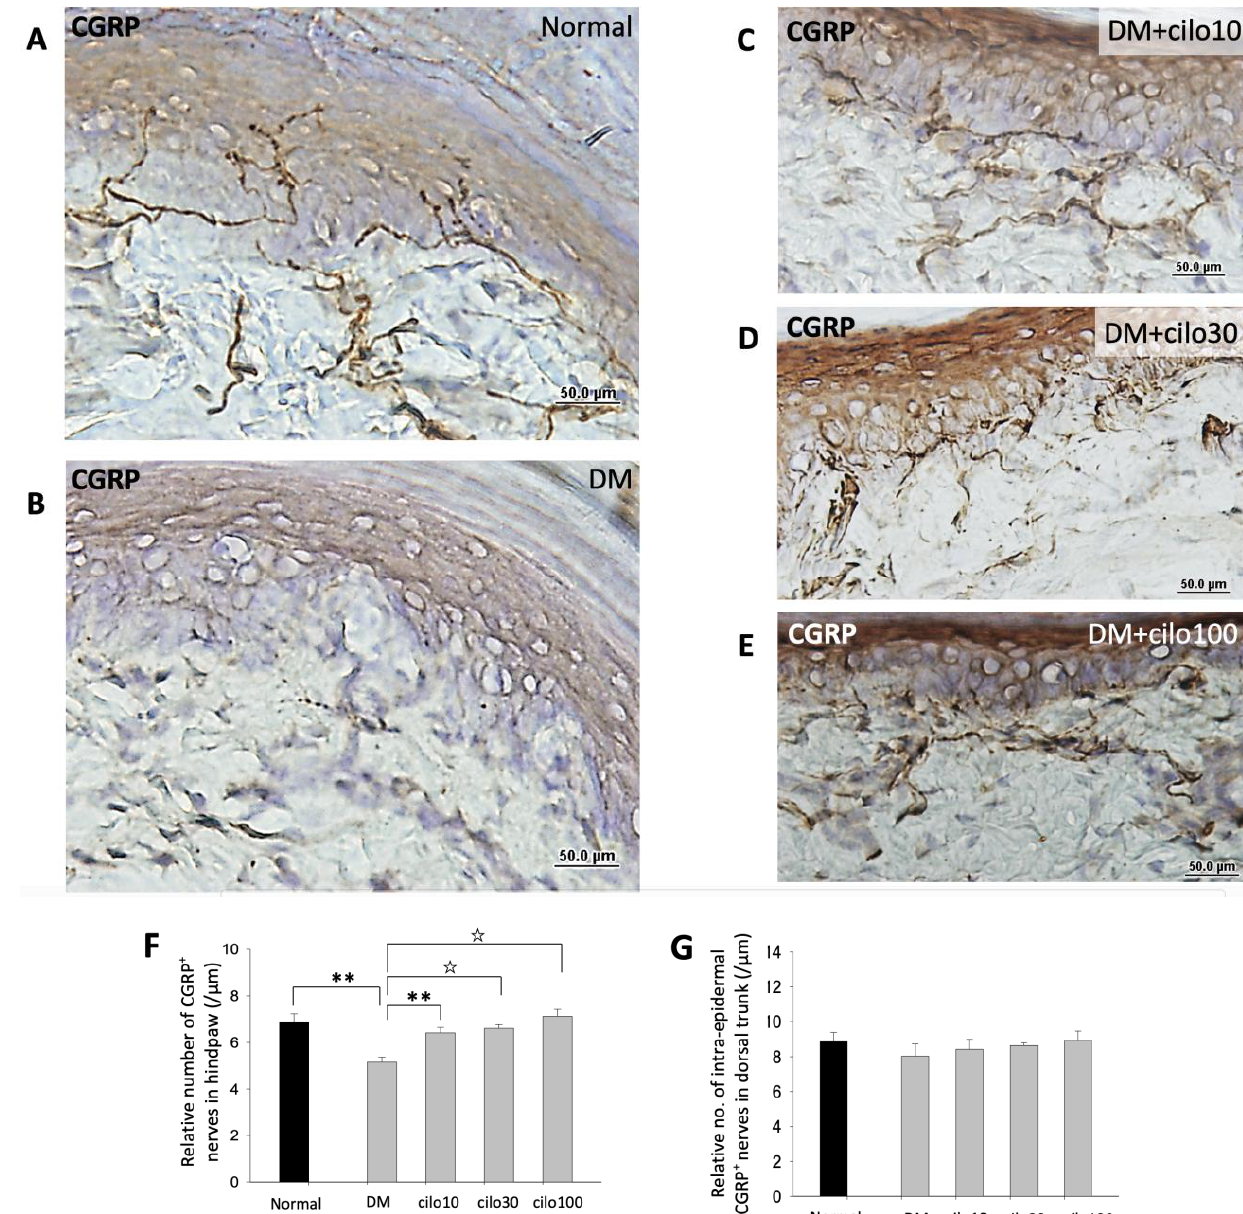
Figure 4. Increased levels of CGRP-positive sensory nerve endings in hind paws of diabetic (DM) rats treated with cilostazol (cilo). CGRP immuno-labeled sensory nerve fibers are indicated by white arrowheads in cryo-sectioned hind paw samples from ( A ) control rats, ( B ) DM rats, and DM rats receiving ( C ) 10 mg/kg (Cilo10), ( D ) 30 mg/kg (Cilo30), and ( E ) 100 mg/kg (Cilo100) daily dosage of cilostazol. Relative density of intraepidermal CGRP-positive nerve fibers ( F ) in the epidermal layer of hind paws or ( G ) in the epidermal layers of the back trunk skin is shown. Cilo10, 10 mg/kg cilostazol; Cilo30, 30 mg/kg cilostazol; Cilo100, 100 mg/kg cilostazol. Bars represent the average number of detectable labeled fibers in 5 mm skin sections. ** Indicates p < 0.01, and ☆ at p < 0.001, Mann – Whitney U test. Error bars represent SE.